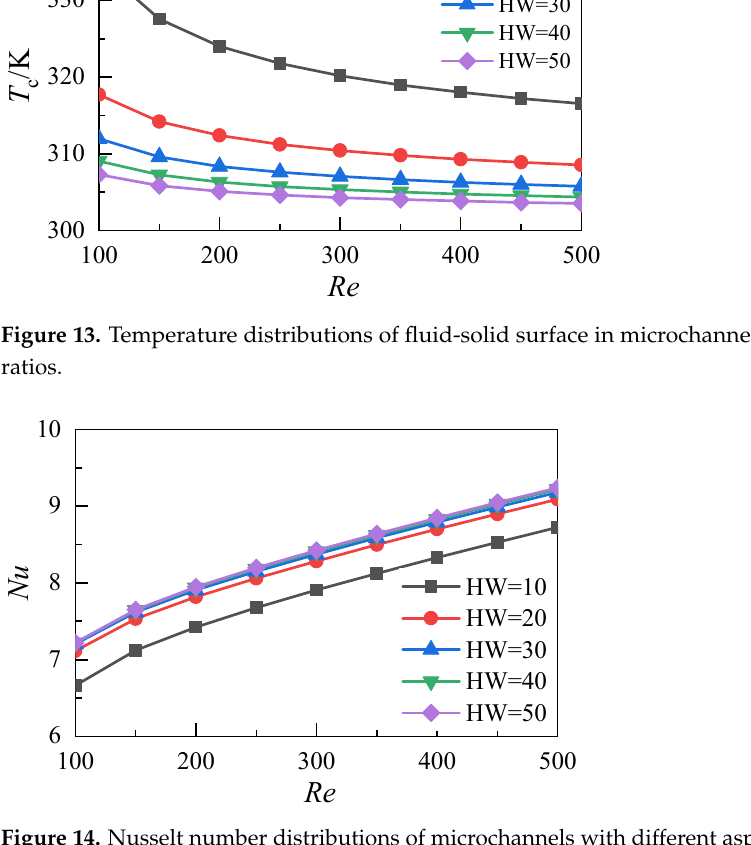
Figure 15. Comparisons of comprehensive heat transfer performances of microchannels with differ- ent aspect ratios.